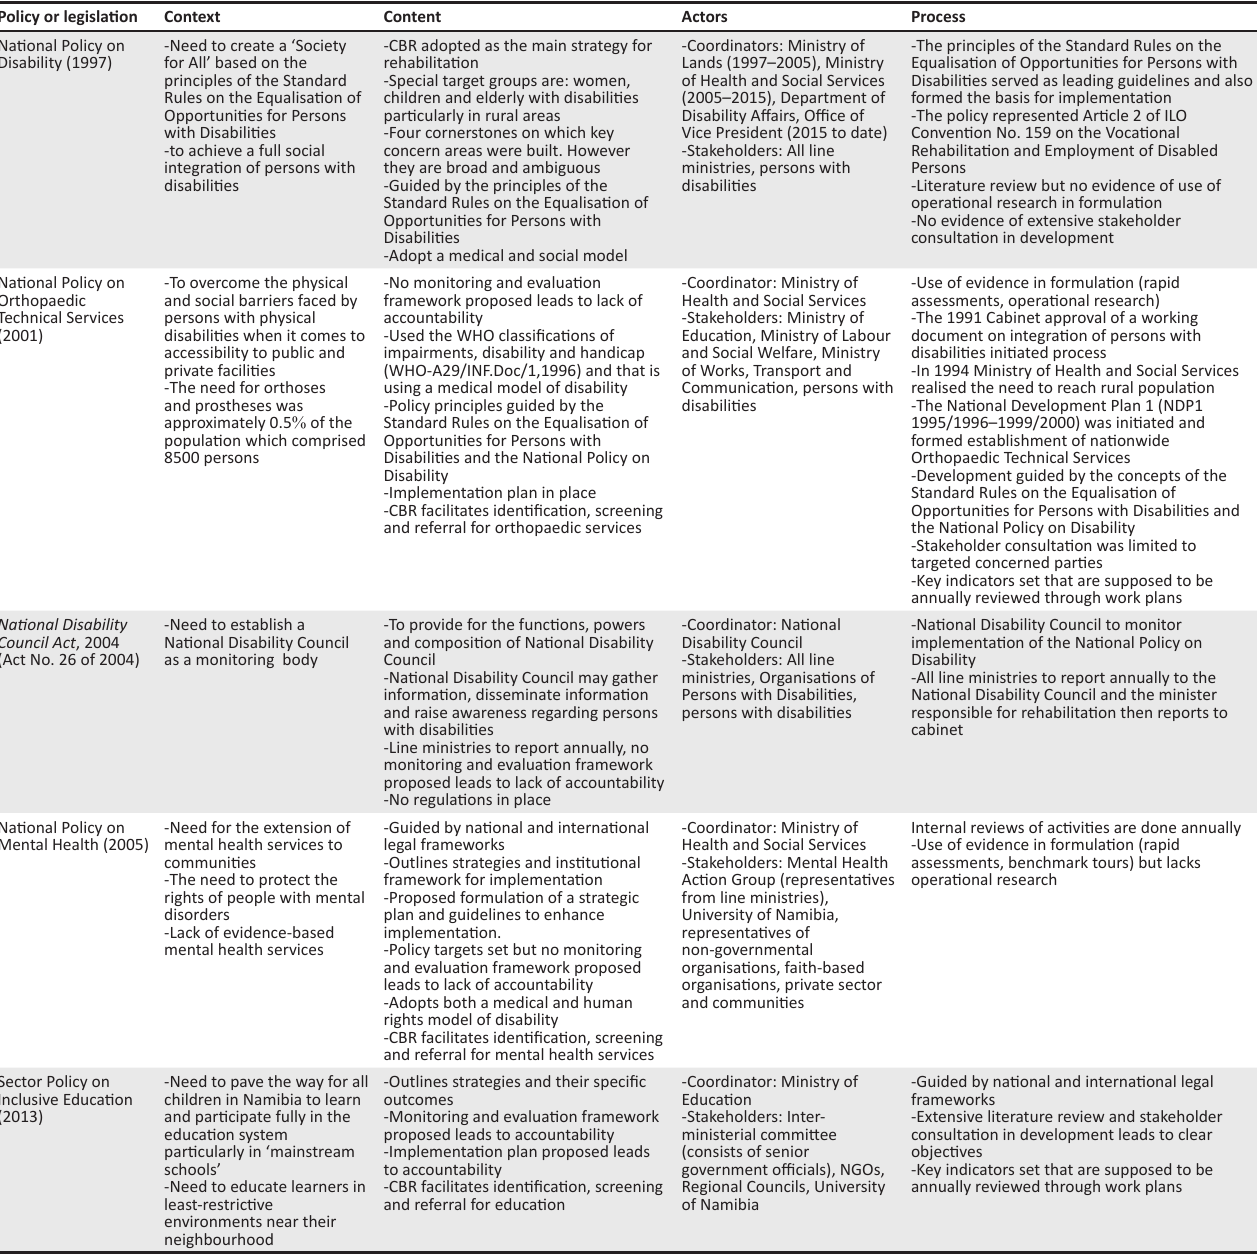
TABLE 2: Context, content, actors and process in the development of policy and legal framework in